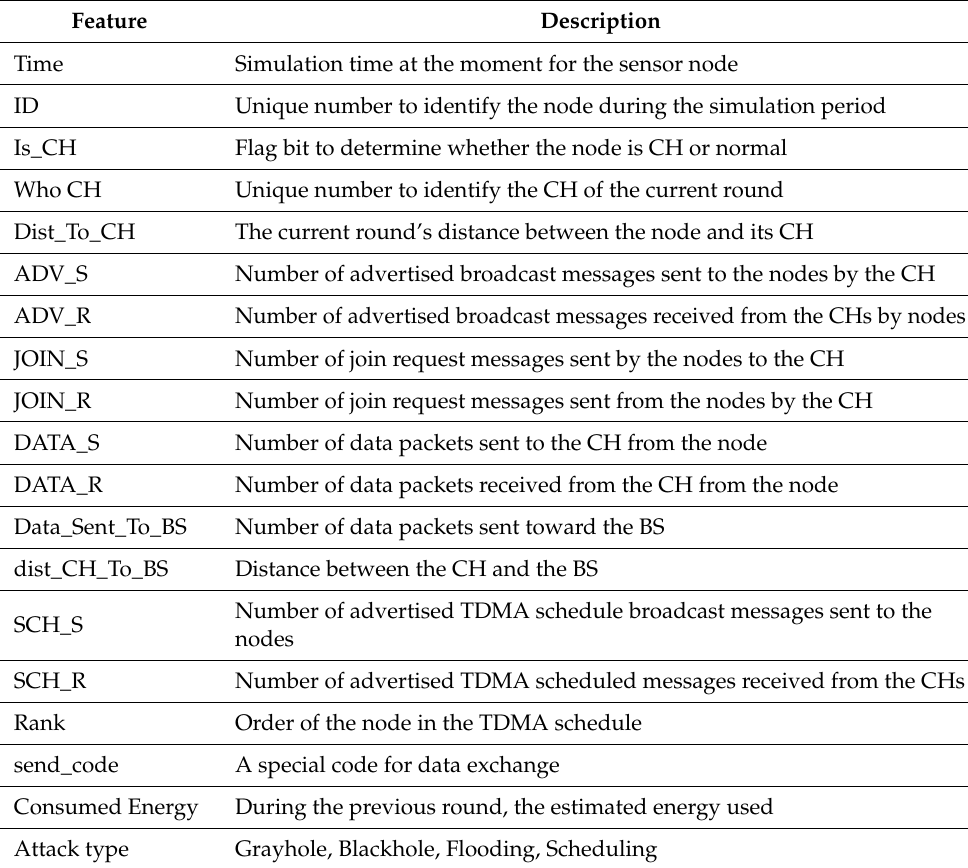
Table 3. Key Features of Dataset